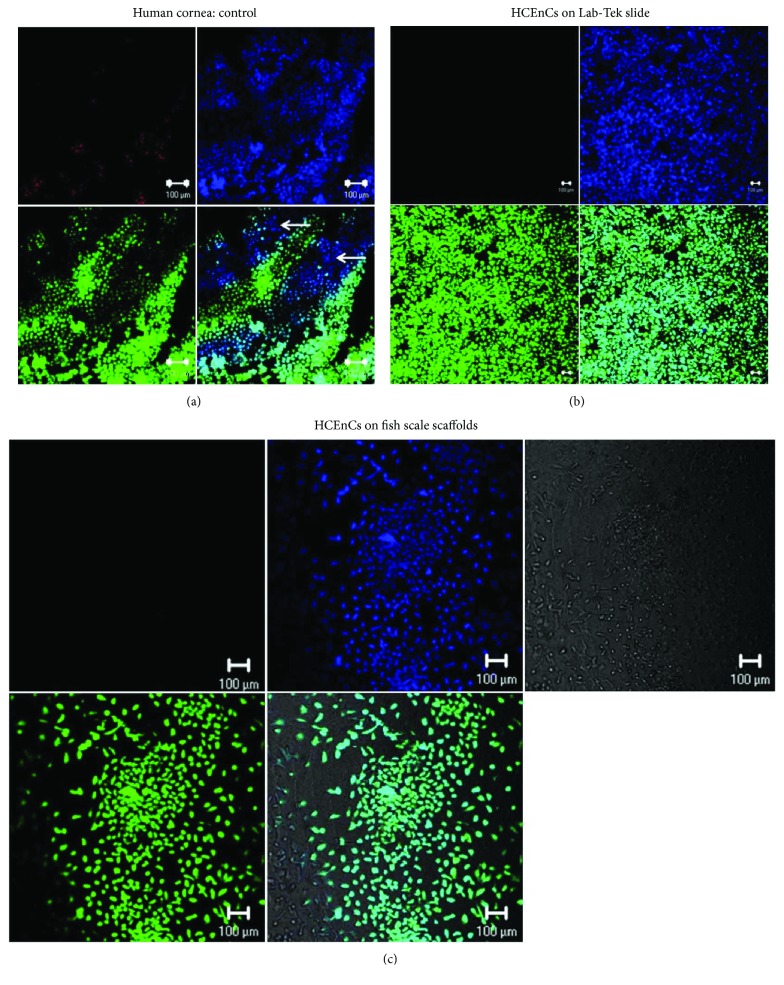
Triple staining using HEC to determine live/dead cells. (a) Control cornea to show the presence of dead (red), live (green), and dying cells (blue without green marked with white arrows). Cell nuclei are shown in blue cells. (b) HCEnCs from old donor corneas cultured on Lab-Tek showed high viability and confluency without any dead cells. (c) Relatively lesser amount of cells was observed when HCEnCs were cultured on FSS. There were no dead cells observed on FSS too, but again, most of the cells were cultured in quadrants 2 and 3. HCEnCs: human corneal endothelial cell; FSS: fish scale scaffold.